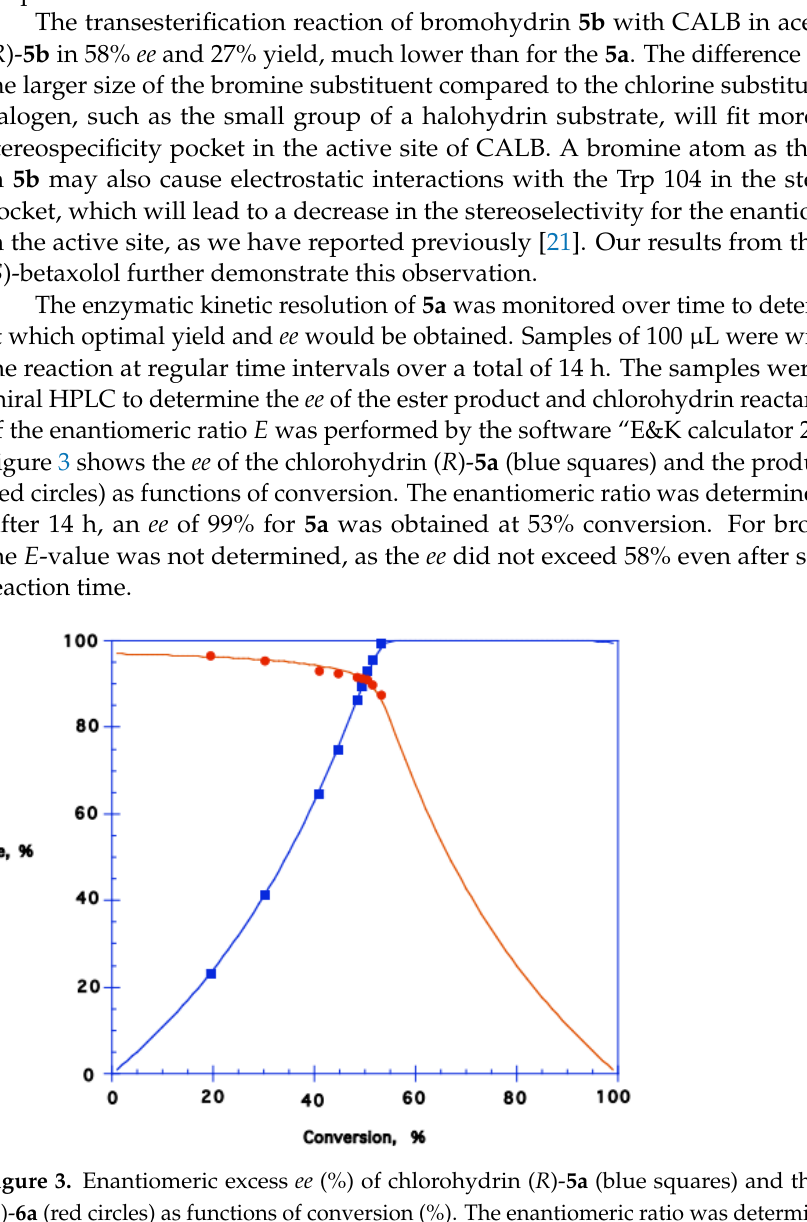
Scheme 5. Synthesis of ( S )-betaxolol (( S )- 7 ) in 95% yield and 99% ee by amination of chlorohydrin ( R )- 5a (99% ee ) with isopropylamine in methanol.